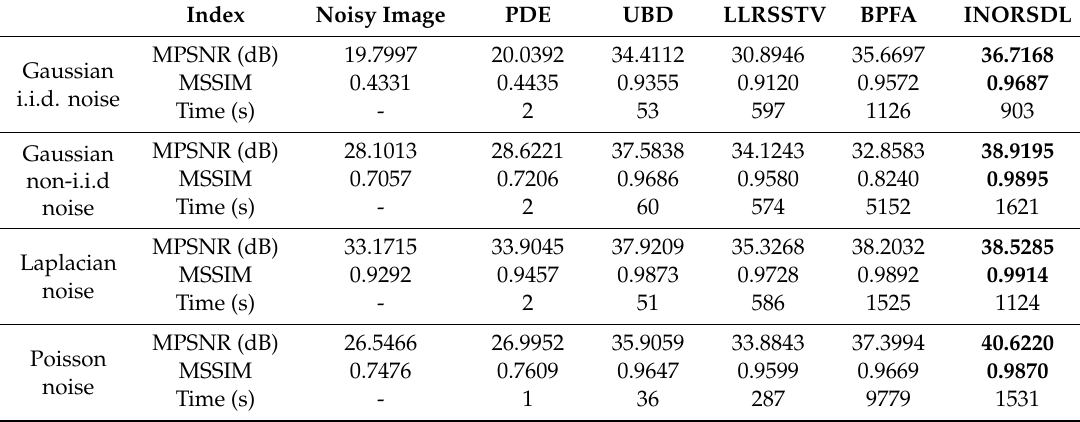
Table 1. Performance comparison of di ff erent hyperspectral inpainting algorithms applied to Pavia Centre dataset.